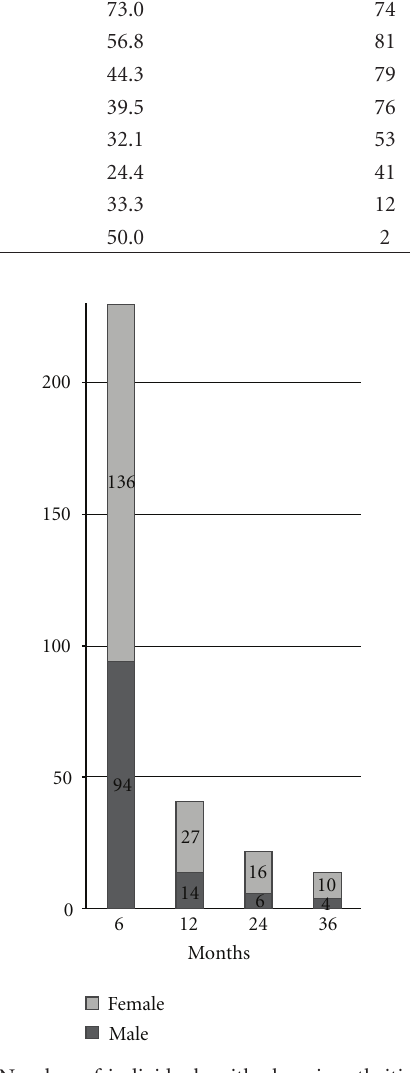
Figure 3: Number of individuals with chronic arthritic disability (CAD) at